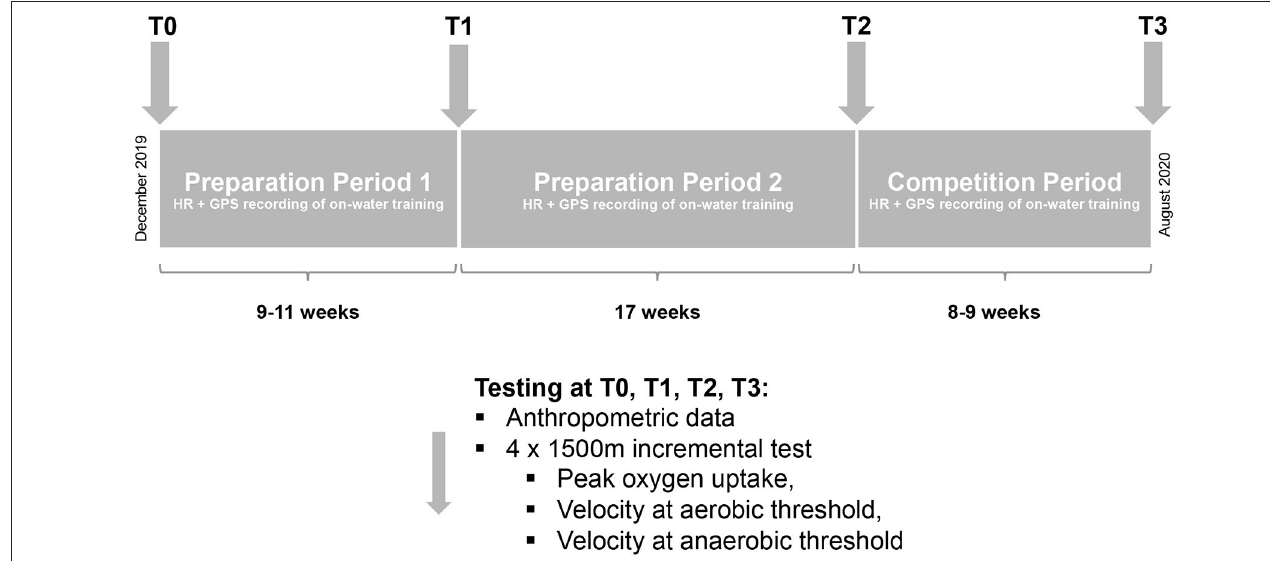
FIGURE 1 | The overall study design. HR, heart rate; GPS, global positioning system; T, Time-point of testing.